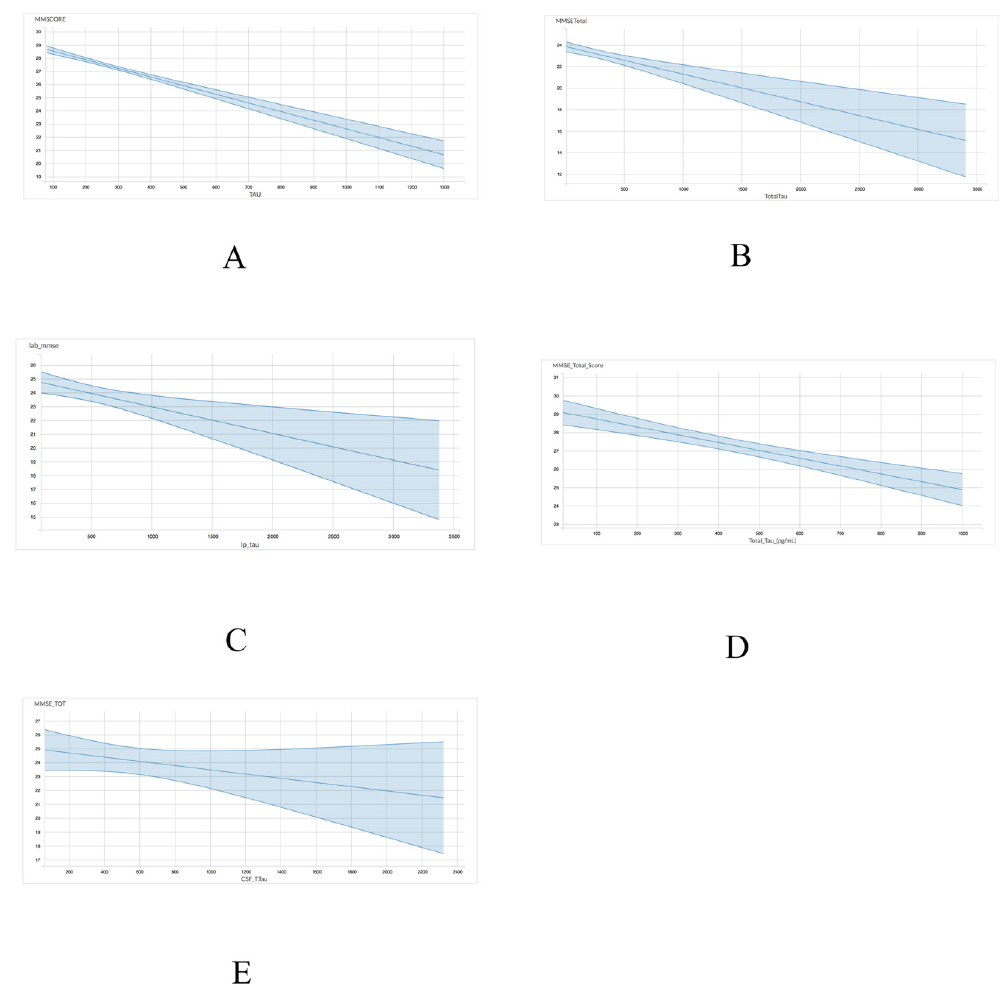
Figure 1. Graphical representation for the correlations between total tau and MMSE in 5 datasets from GAAIN database. ( A ) ANDI, ( B ) INDD, ( C ) CBAS, ( D ) DESCRIPA, and ( E ) EPINETTE.